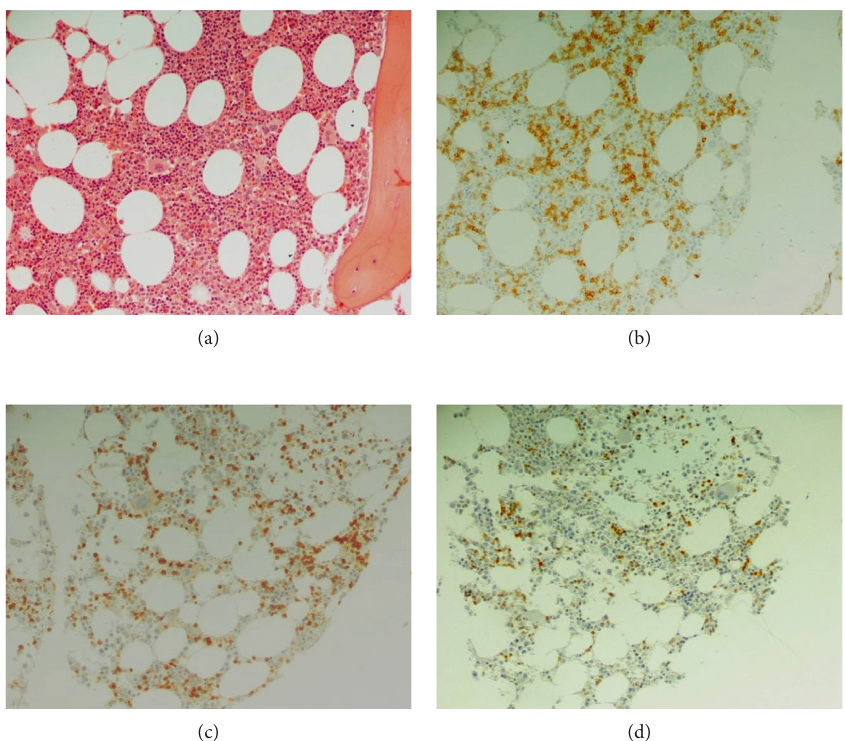
Figure 2: Bone marrow biopsy with limited interstitial infiltration by CLL. The neoplastic cells were small and round (a) (H&E staining, magnification × 200) expressing CD20 (b), CD5 (c), and CD23 (d) (DAB, magnification ×